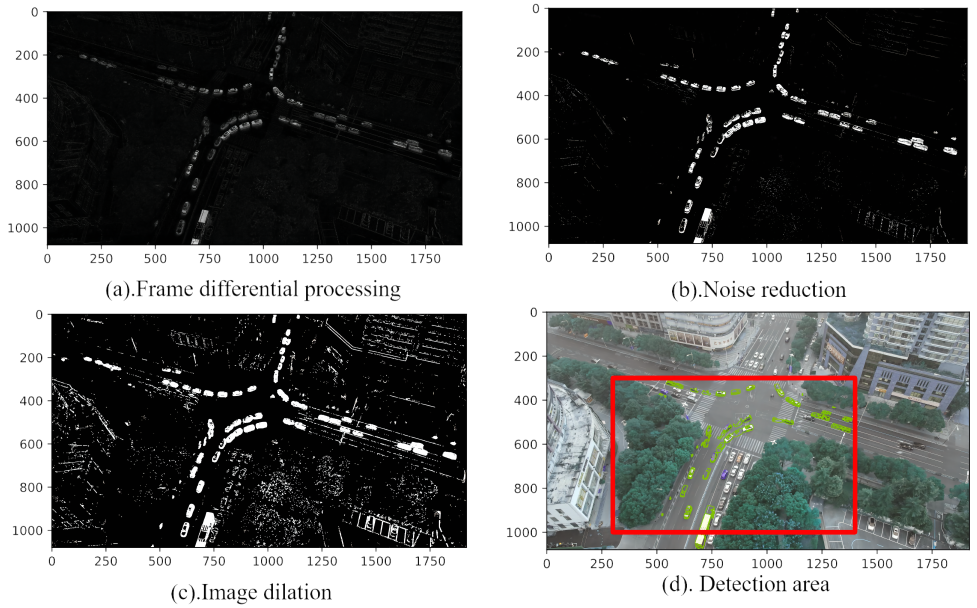
Figure 8. UAV video process. ( a ) Frame difference processing. ( b ) Thresholding. ( c ) Image dilation. ( d ) Select the detection area and draw the